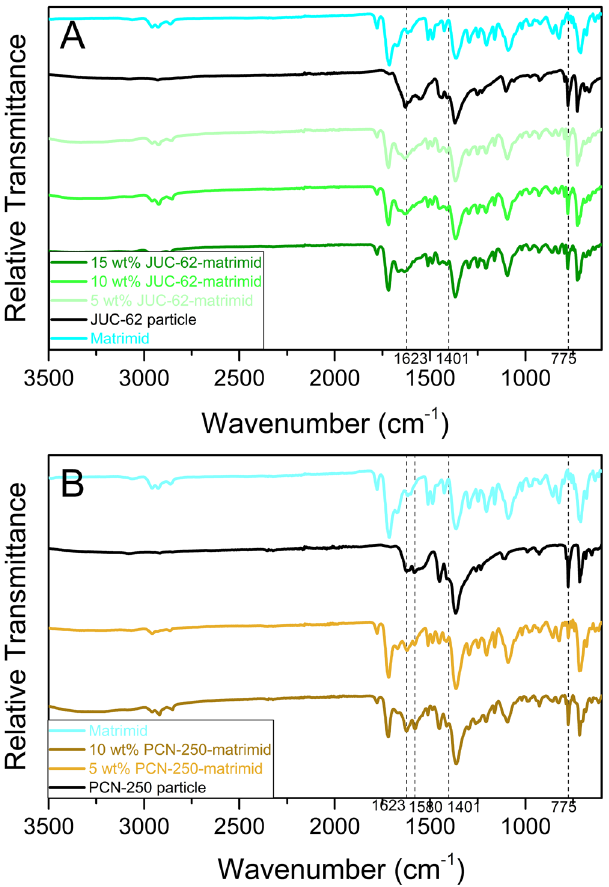
Figure 2. FTIR Spectrum of JUC-62 ( A ) and PCN-250 ( B ) matrimid mixed matrix membrane.